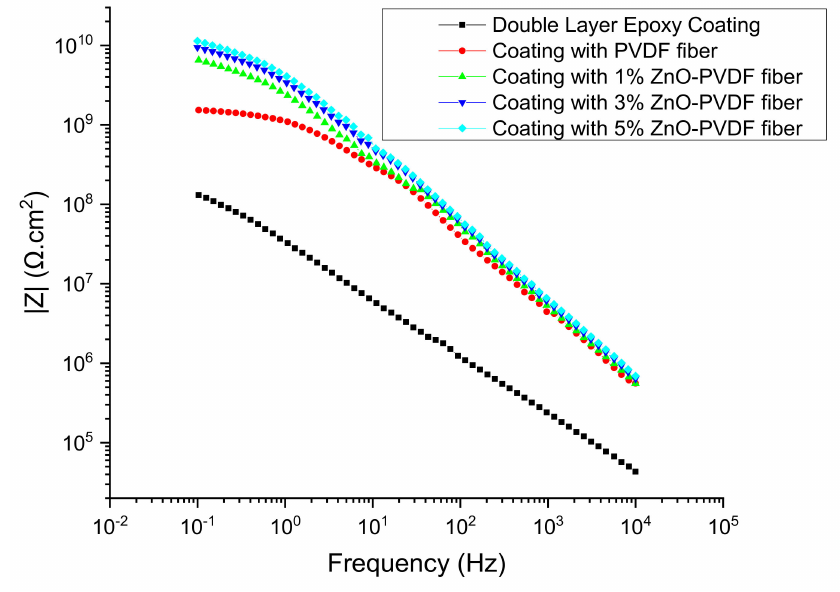
Figure 8. Bode magnitude plot for all samples on day 0 in the 4.2% sea salt solution.